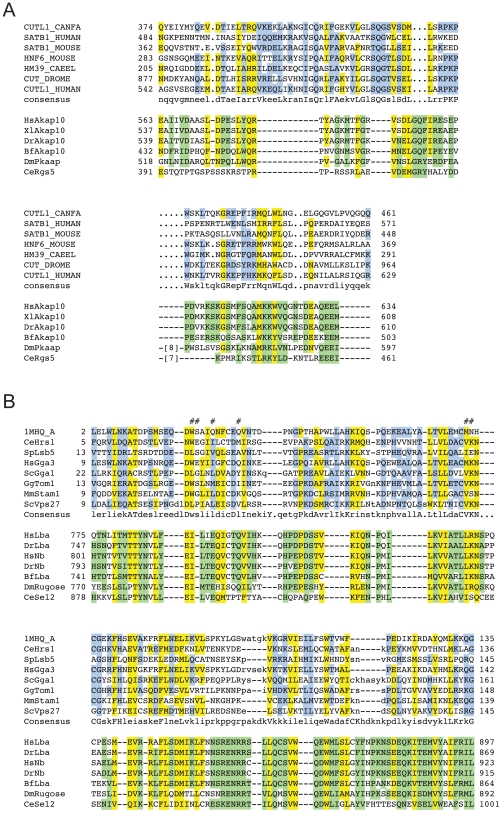
Multiple sequence alignments of remotely conserved domains found in proteins associated with human diseases.(A) Multiple sequence alignment of the AKAP10 family with the CUT-like HLH domain family. (B) Multiple sequence alignment of the Lba protein family with the VHS domain family. Residues that are conserved between the two families are highlighted in yellow, those found in only one of them are highlighted in blue and green, respectively. Essential, functional residues retrieved from the CD database are indicated by hash keys. Accession numbers of sequences can be found in Supplemental Table S7.